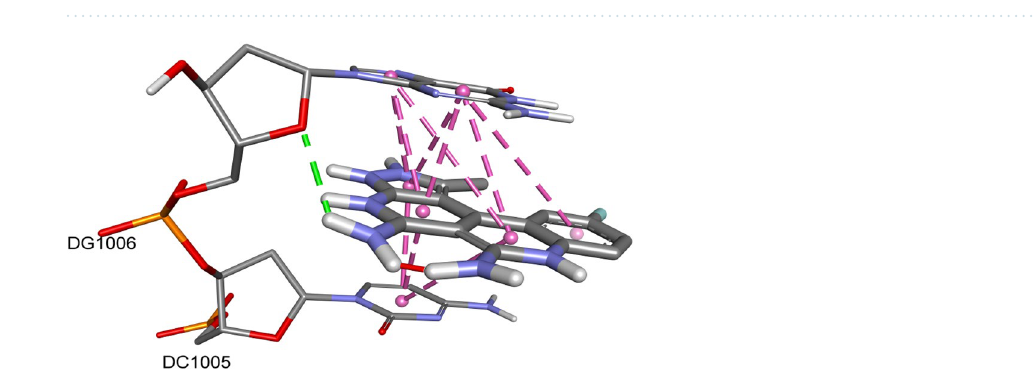
Figure 4. Absorption spectra of 200 μM of 5j in absence (0 μM) and presence (66, 132, 198, 264, 330 and 396 μM) of DNA. The arrow direction shows increasing concentration of DNA. The graph is the plot of A°/ (A-A°) versus 1/[DNA] for the determination of binding constant and Gibb’s free energy of 5j-DNA product.